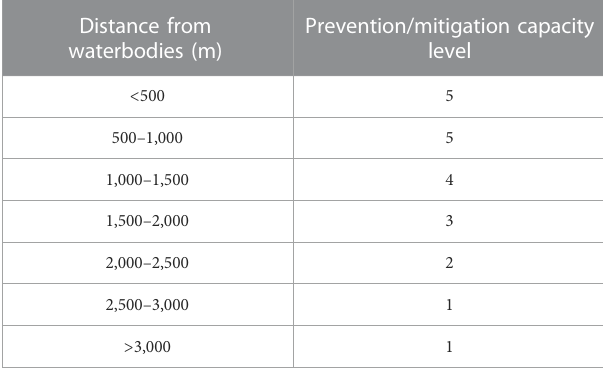
TABLE 7 Classi fi cations of distance from waterbodies.